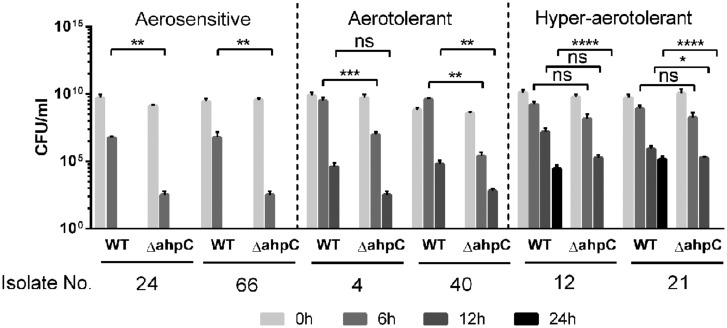
Growth defects in the ahpC mutants under aerobic conditions. The results show the CFU levels of triplicate samples after 6, 12, and 24 h culture under aerobic conditions with shaking at 200 rpm. The strains were selected from the three different aerotolerance groups. The experiment was repeated at least three times, and similar ∼results were ∼observed in all experiments. Statistical significance was determined with two-way ANOVA using GraphPad Prism 6 (GraphPad Software, inc.). n.s.: P > 0.5, ∗P < 0.05, ∗∗P < 0.01, ∗∗∗P < 0.001, ∗∗∗∗P < 0.0001.